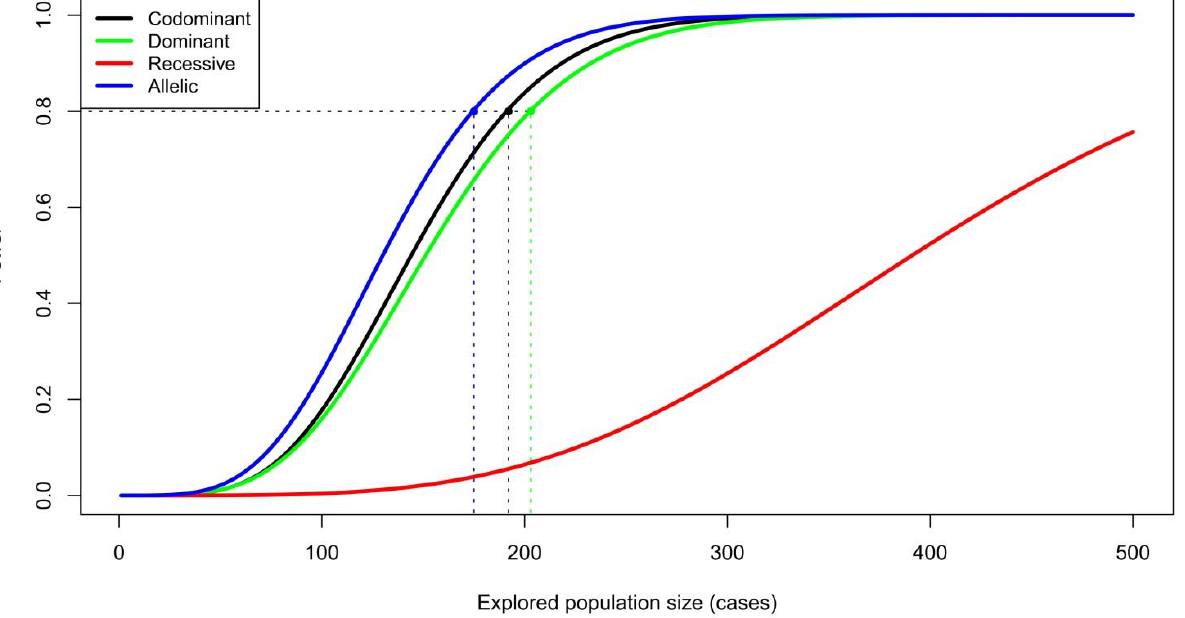
Figure 1. Power of GWAS χ 2 tests. The necessary number of cases was estimated with the following parameters: the control to case ratio = 5, α = 0.05 (Bonferroni -corrected p -value = 1 × 10 −7 , assuming there will 400,000 markers used in the analysis), disease prevalence = 0.1, minor allele frequency in the control group = 0.1, and the allelic odds ratio = 2.5.